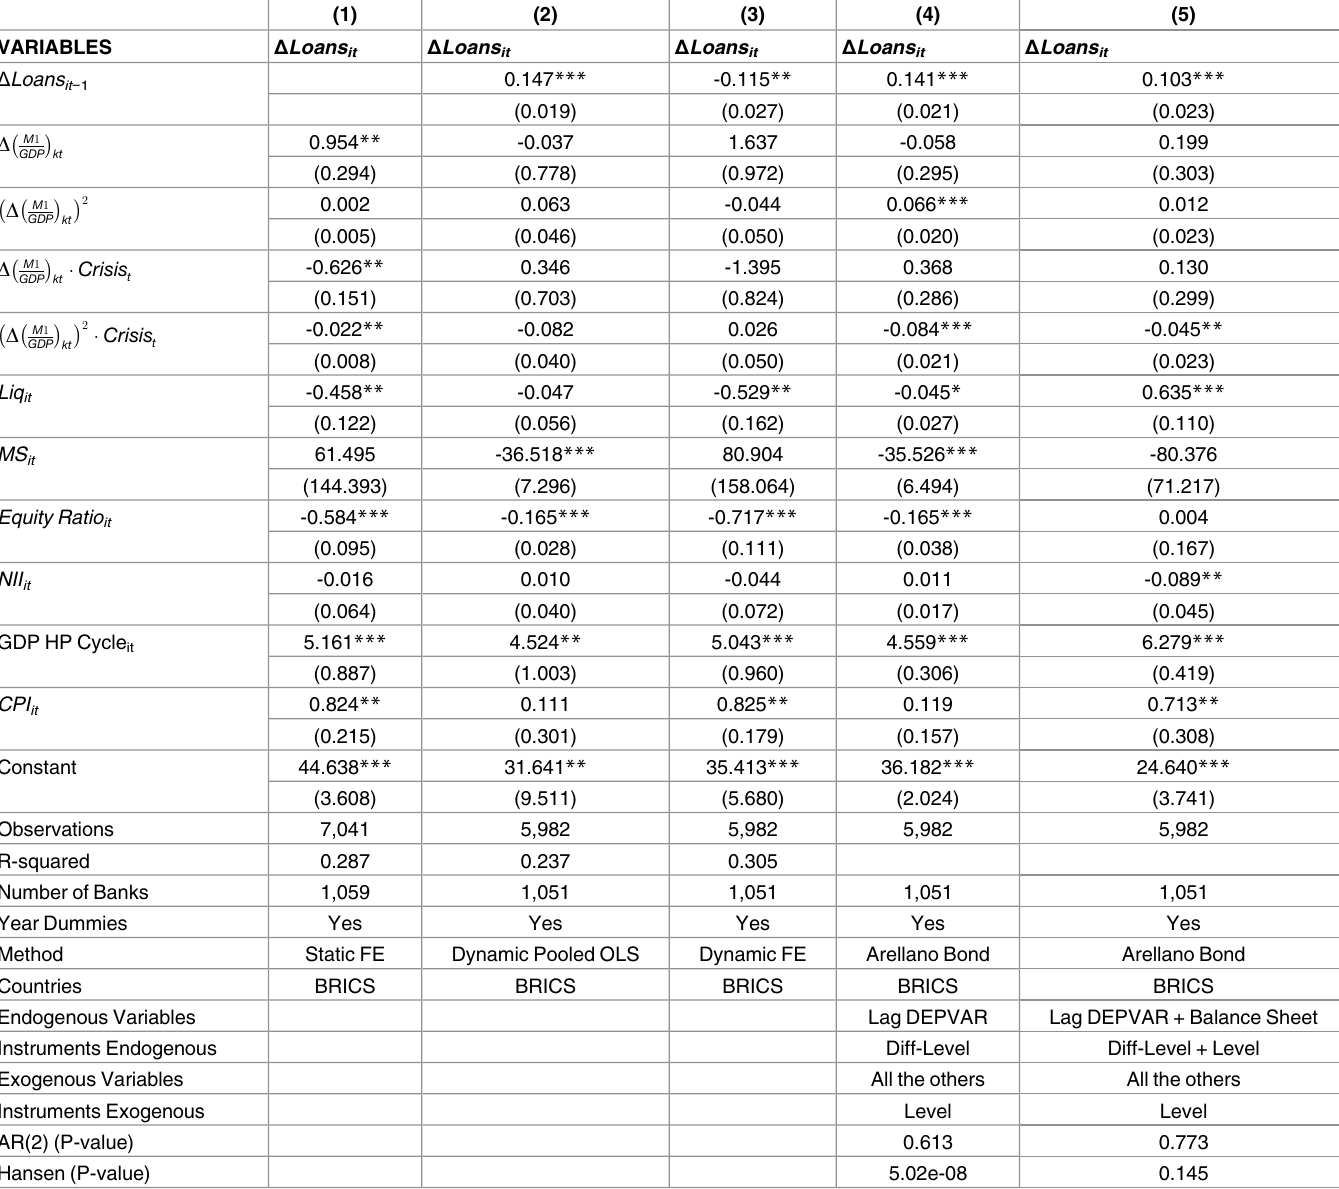
Table 4. Regression of Bank’s Loan Growth on Monetary Expansion D M1